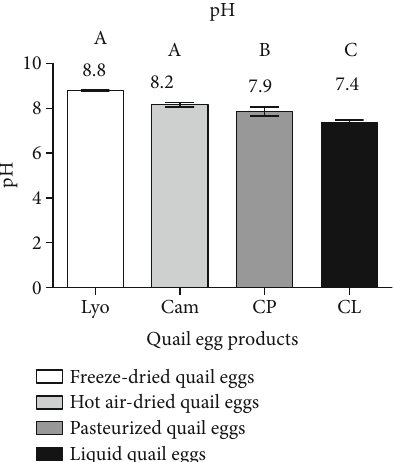
Figure 5: Fat content of liquid (CL), freeze-dried (Lyo), hot air- dried (Cam), and pasteurized (CP) quail